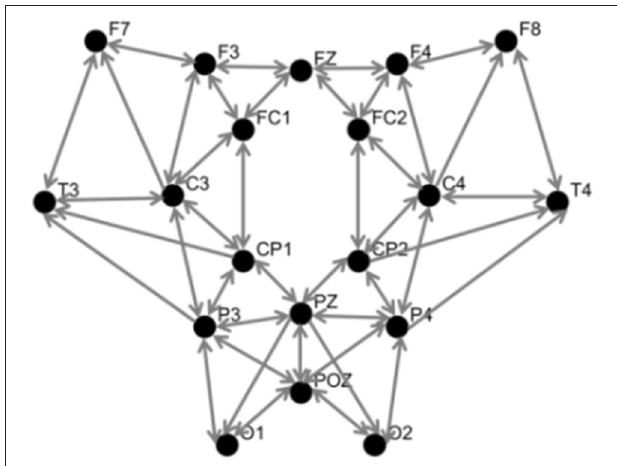
FIGURE 4 | Topographic view of EEG electrodes showing neighborhood pattern for Laplacian spatial filtering. Inward arrows to each node indicate the corresponding neighbors used for spatial